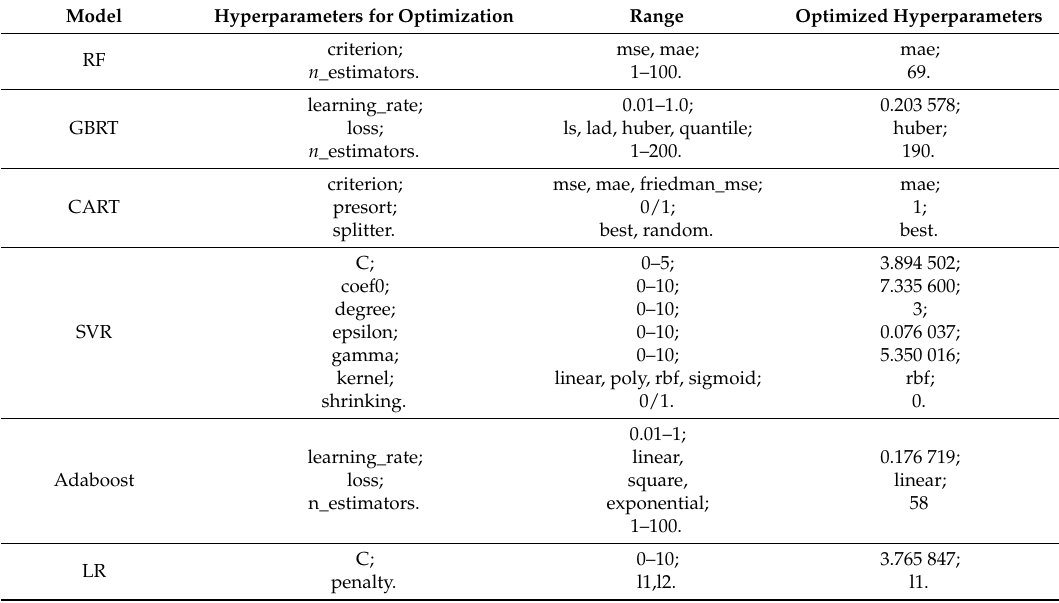
Table A1. Model hyperparameters and their optimization